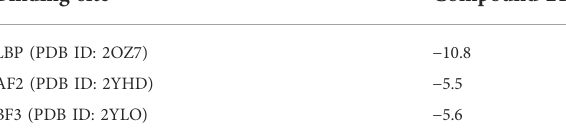
TABLE 3 The binding af fi nities (kcal/mol) of docking of derivative 21 with three binding sites of AR. Binding